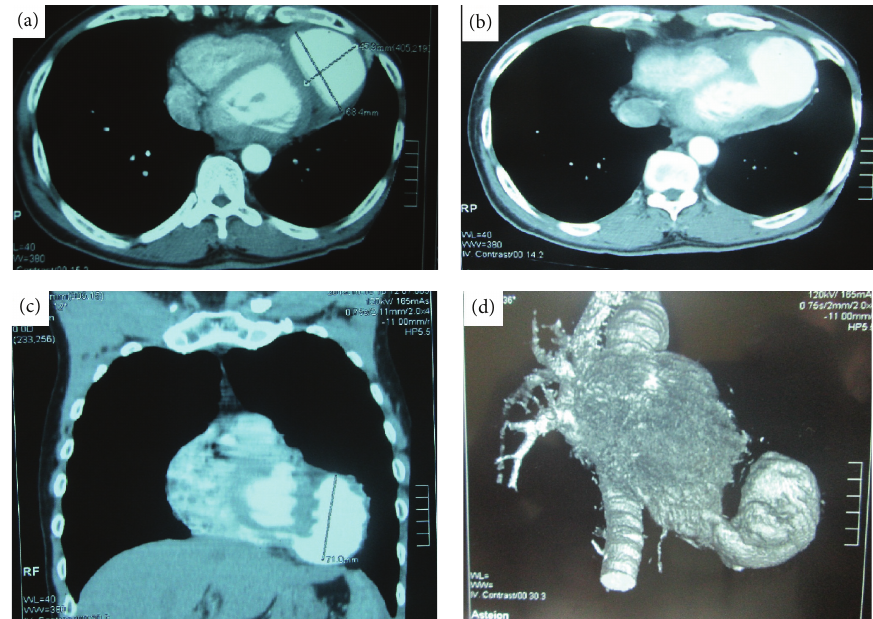
Figure 3: Chest CT scan imaging. (a) Cross-section showing the diameters of the pseudoaneurysm (45.9 mm × 68.4 mm). (b) Visualization of the neck between the left ventricle and the false aneurysm. (c) shows a sagittal diameter of 71mm. (d) 3D reconstruction of the left ventricle communicating with the